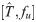
50% Neutral regions of each of the eight gecko patterns in LALI-space.For each of the eight gecko patterns, we identified the neutral region A) in [T^,fu]-LALI-space for the linear Turing implementation or B) in [T,ρ] LALI-space for the non-linear FitzHugh-Nagumo model. The white circle in each neutral region shows the LALI-type chosen to generate representative phenotype clouds in Fig 7 and Fig 10. The labeled stars A and B are the points in LALI-space that are used to generate the “preternatural” patterns in Fig 12. (Both models used the 50% phenotype cloud to generate the 50% neutral region, see the description under “Step 2” in the Methods).